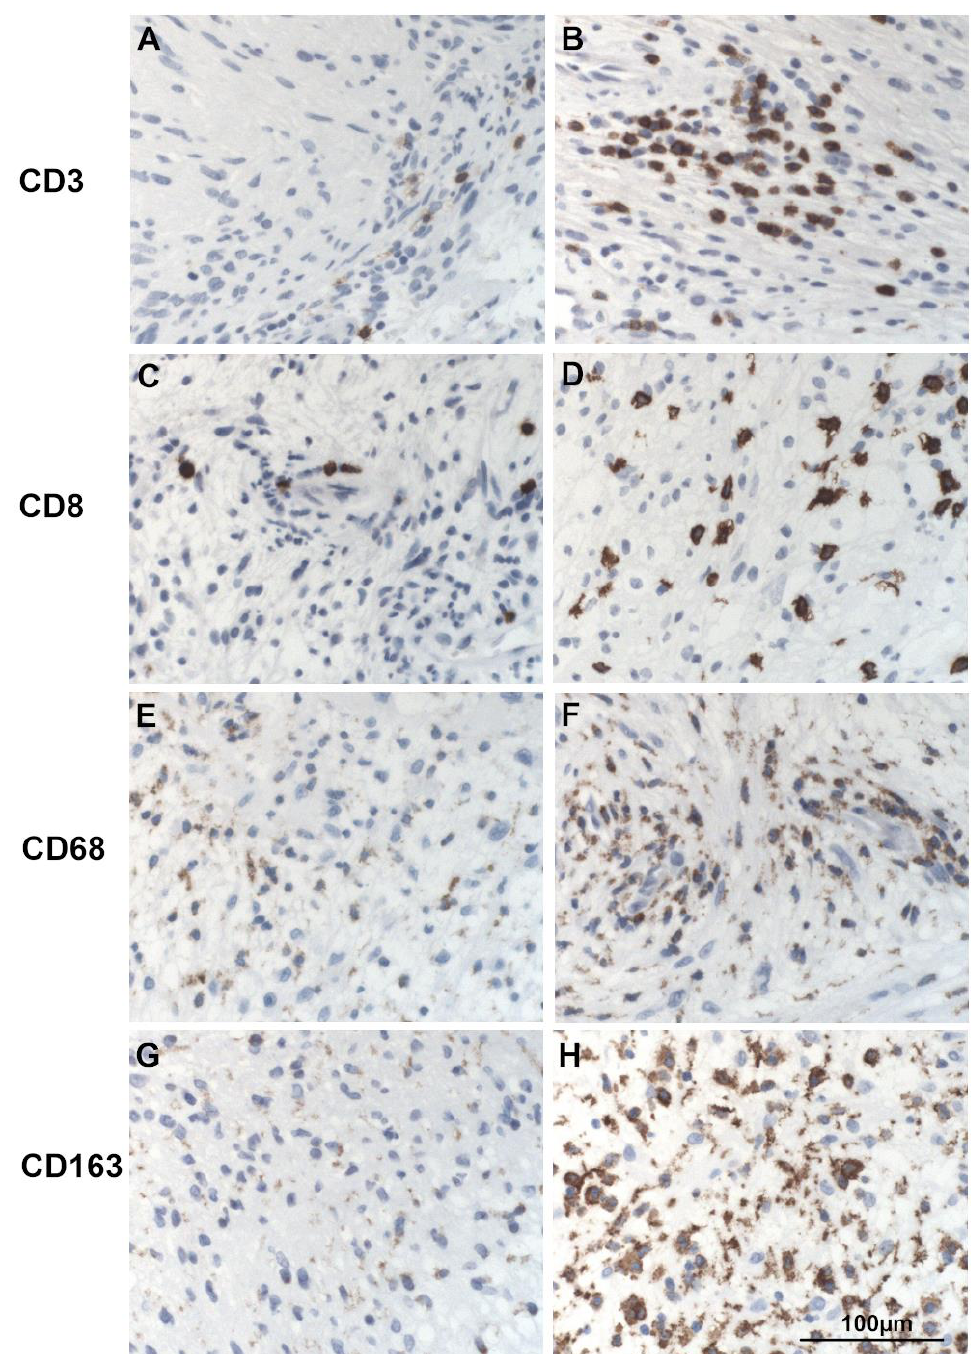
Figure 7. Examples of the immunohistochemical expression differences of lymphocytic and mac- rophage markers in vestibular schwannoma. Cytoplasmic staining of CD3 and CD8 is shown in tumor areas with little ( A , C ) and more pronounced expression ( B , D ). The often perinuclear pro- nounced cytoplasmatic staining of CD68 and CD163 can be seen for cases with low to absent ( E , G ) and high expression ( F , H